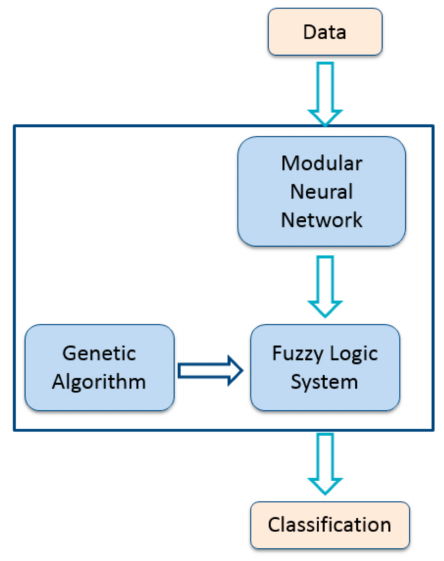
Figure 1. General Neuro Fuzzy Hybrid Model.